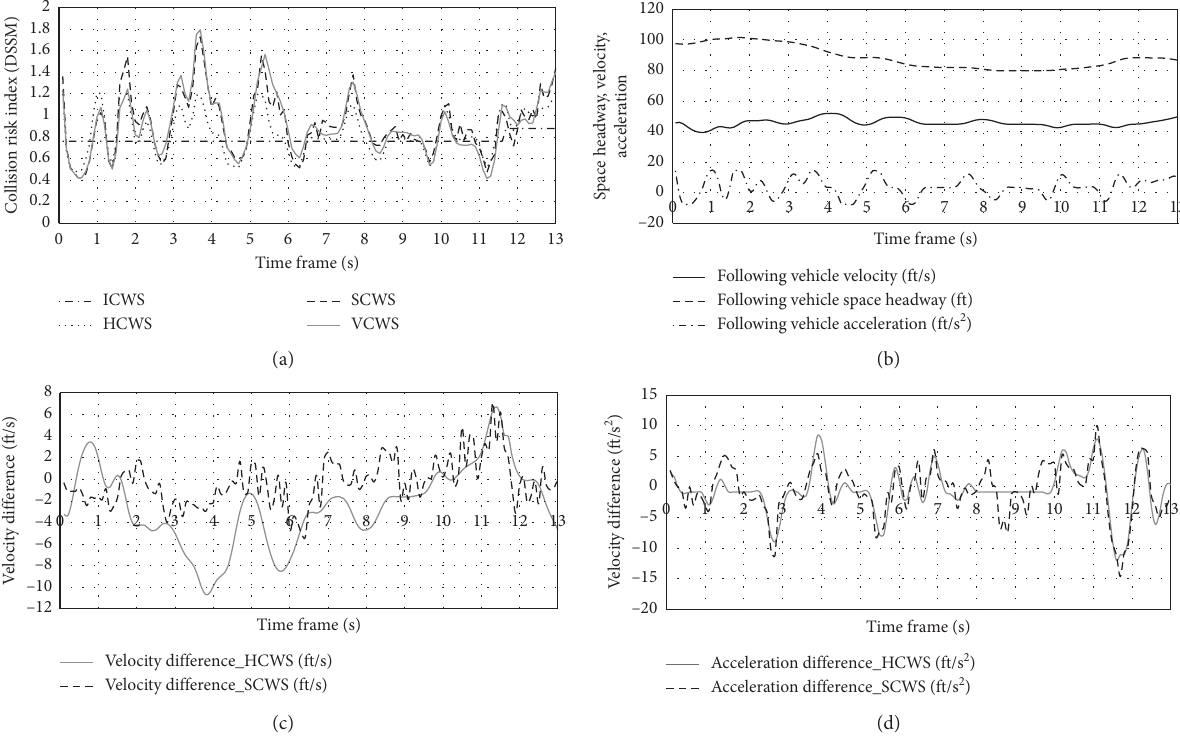
Figure 6: Disaggregation level comparison of collision risks calculated using four different collision warning systems for car-following Case 1 in terms of (a) DSSM, (b) driving data, (c) estimated velocity, and (d) estimated